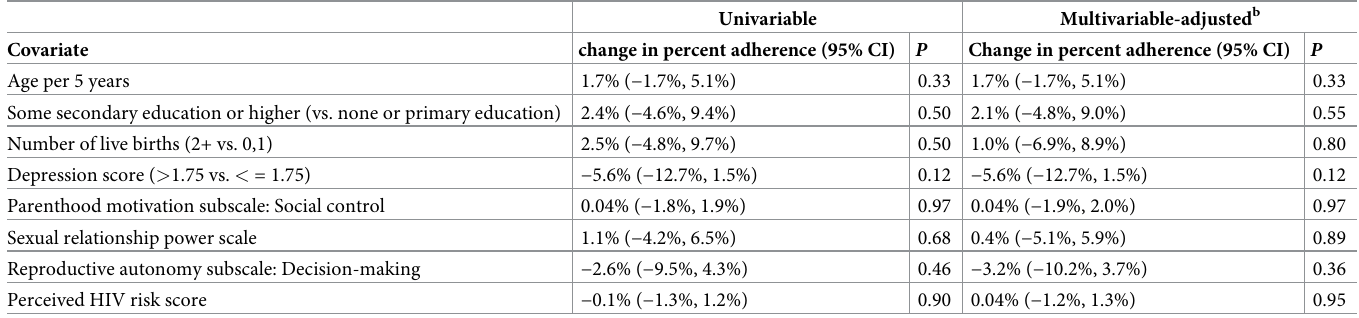
Table 2. Univariable and multivariable-adjusted change in mean (95% CI) adherence a to PrEP during 3 months following initiation.